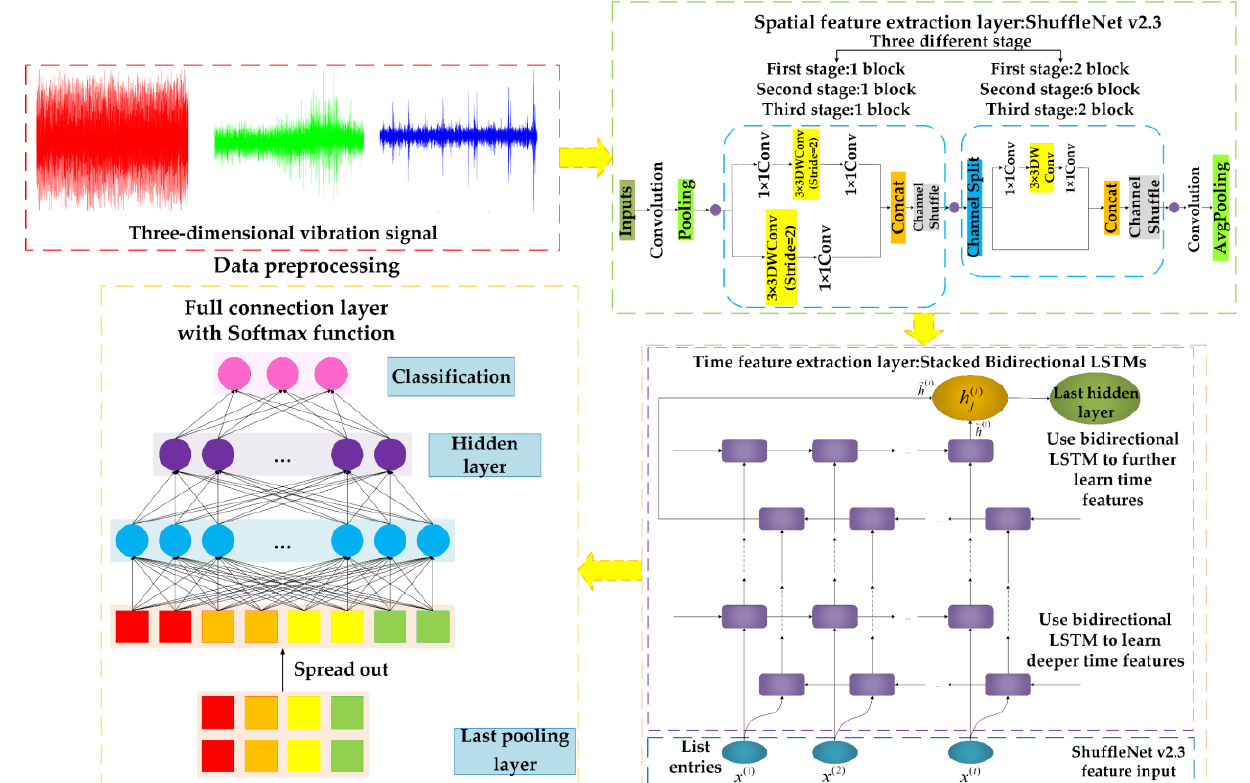
Figure 3. ShuffleNet v2.3-StackedBiLSTM tool wear state recognition model. Table 2. Broaching tool state recognition model details.